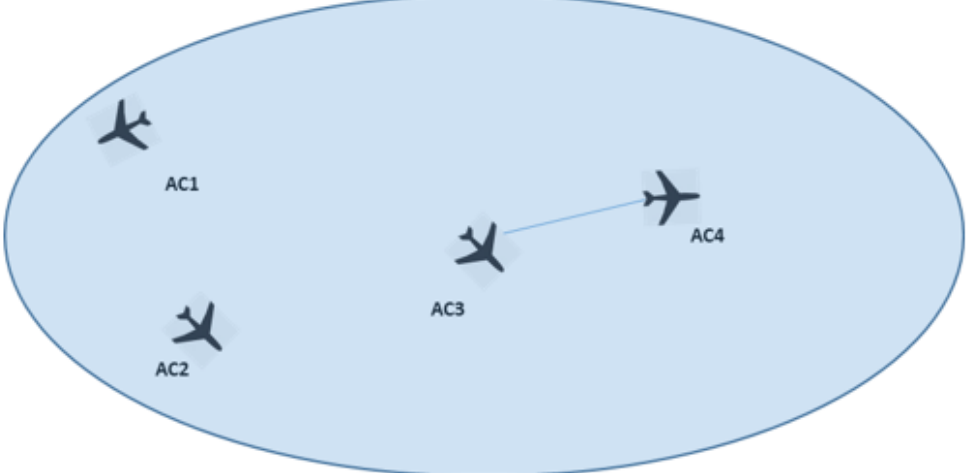
Figure 1. The edge density